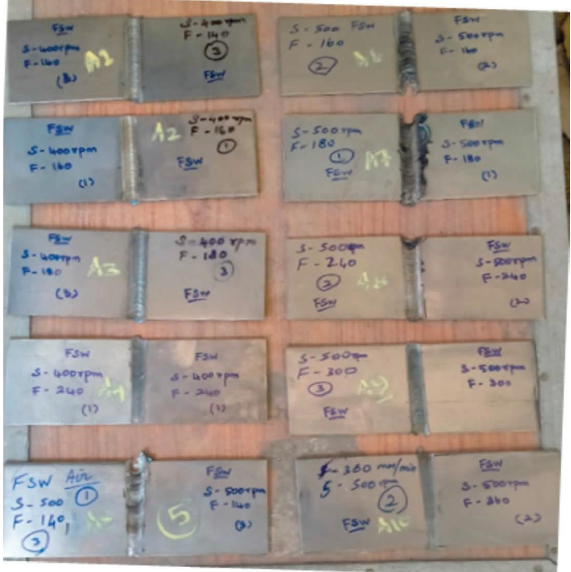
Figure 2: Friction stir welded joints at diferent process parameters.